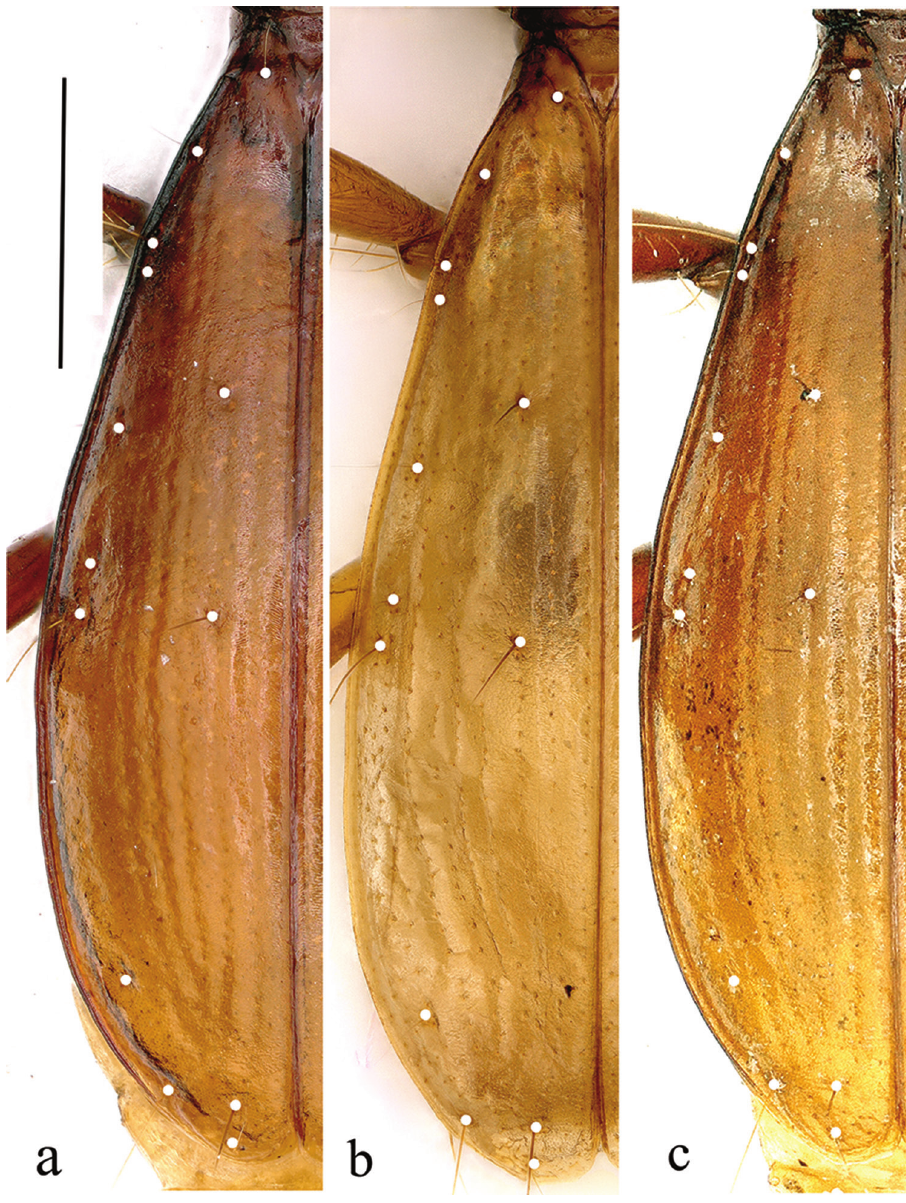
Figure 6. Left elytron of Dongodytes (s. str.) species, chaetotaxy shown by white points a D. tonywhitteni sp. n. b D. fowleri c D. grandis . Scale bar: 1